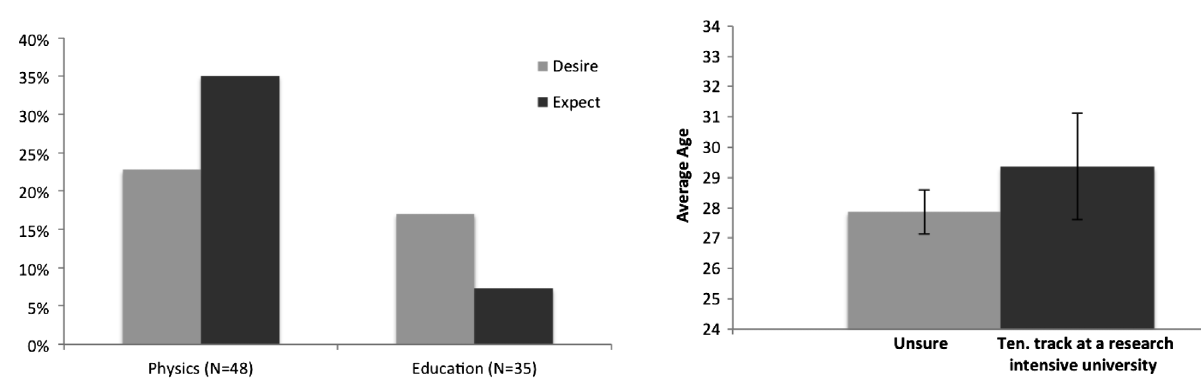
FIG. 5. Percentage of PER graduate students reporting wanting and expecting to hold a tenure track position at a research intensive university (values are the percentage of the subgroup the populations).